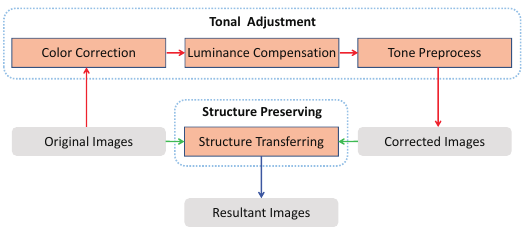
Figure 2. The flowchart of our tonal correction algorithm.